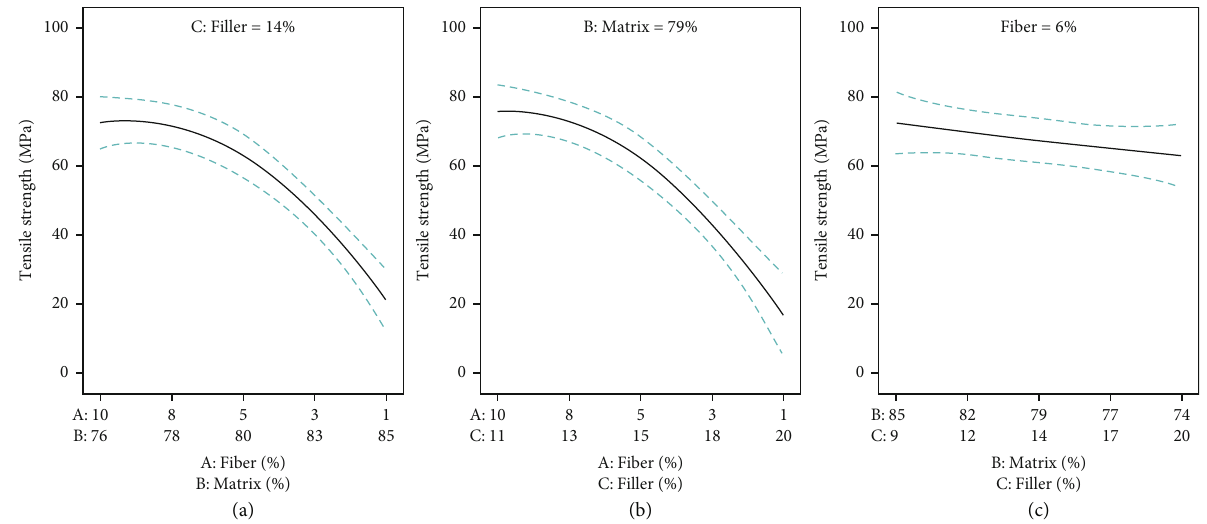
Figure 8: E ff ect of (a) fi ber loading as a function of the matrix and (b) fi ber loading as a function of fi ller on tensile strength.